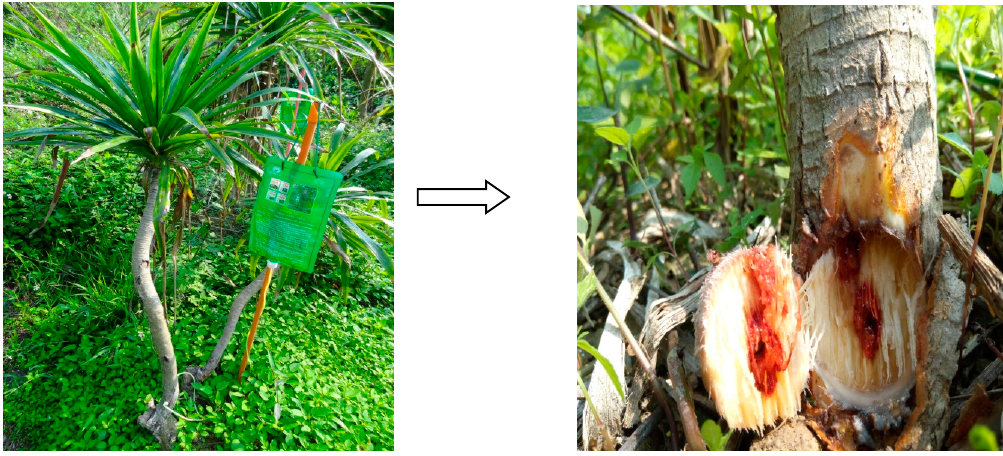
Figure 5. Resina Draconis produced in the stem xylem of D. cochinchinensis trees after chemical solution induction for 80 days.